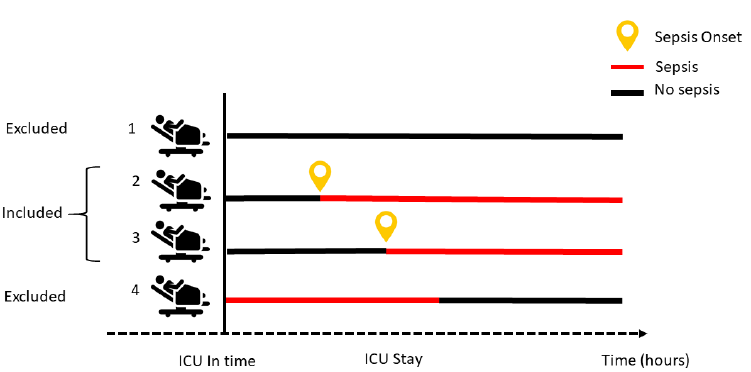
Figure 3. Inclusion and exclusion criteria for